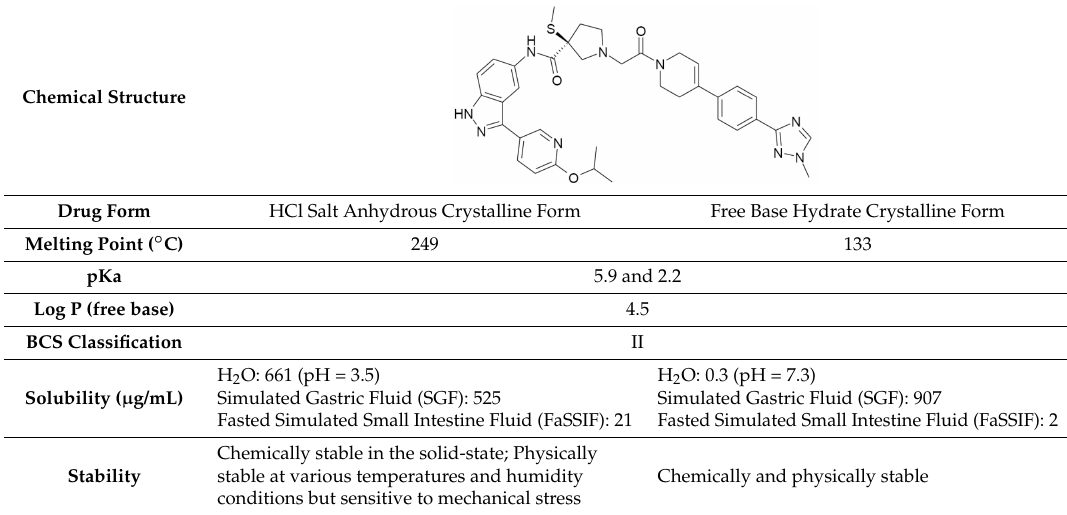
Table 1. Physical/chemical properties of MK-A.